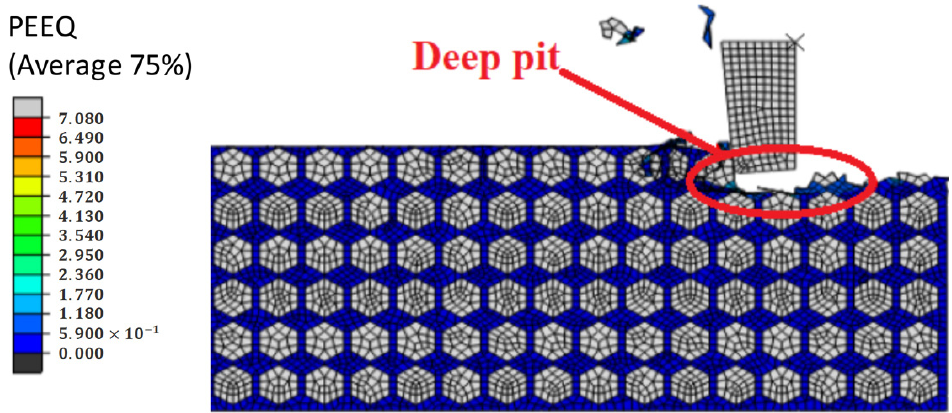
Figure 22. Simulation results of a deep pit on a machined surface.